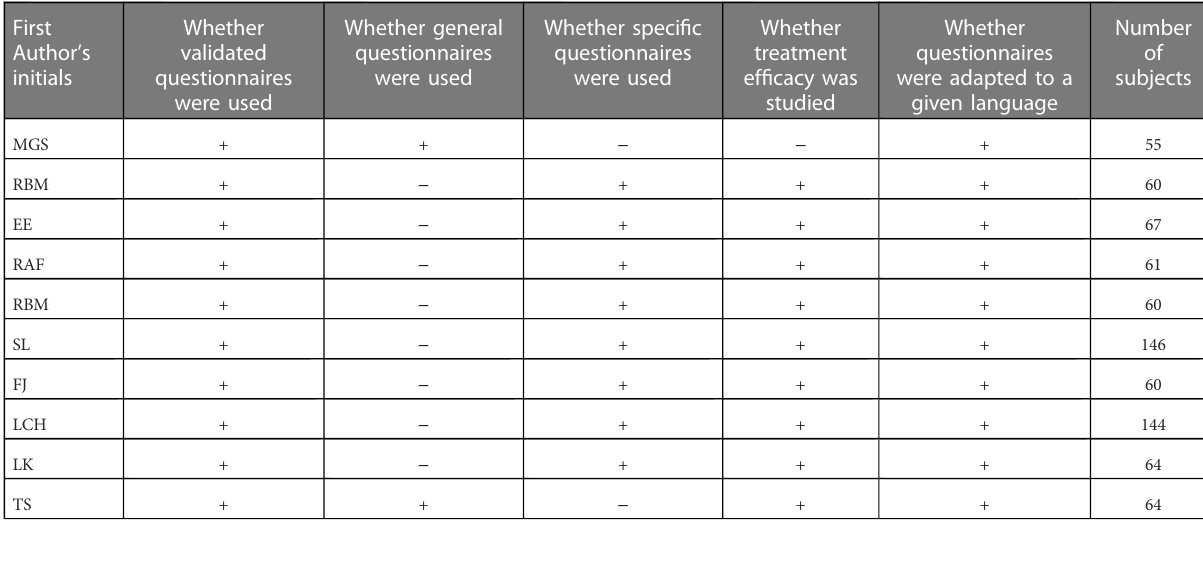
TABLE 1 Chosen HRQoL studies on tonsil hypertrophy.